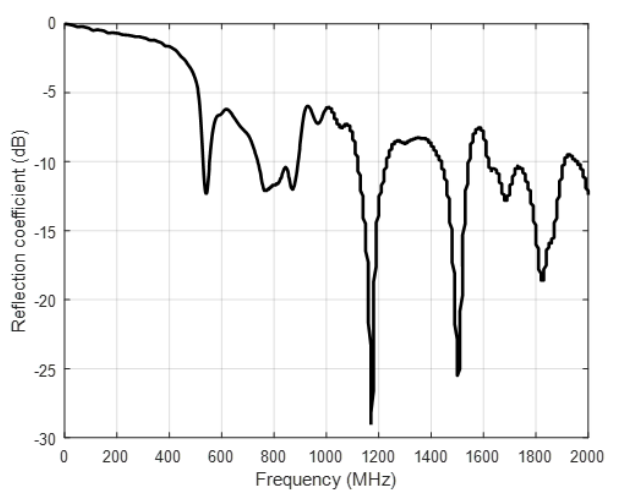
Figure 5. Measured reflection coefficient of the external UHF sensor.